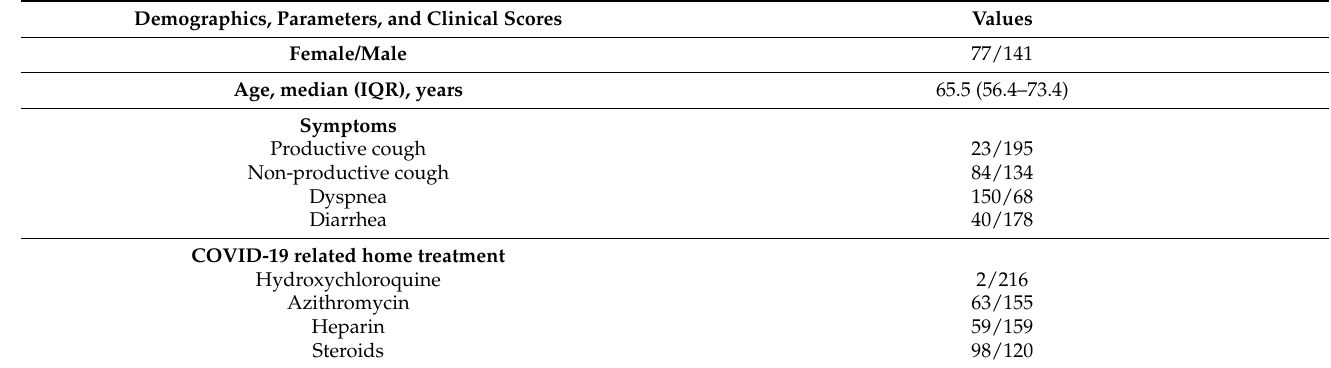
Table 3. Demographic and baseline characteristics of the studied population. Data are expressed as number of patients or median (interquartile range, IQR) when appropriate. * refers to data obtained with oxygen